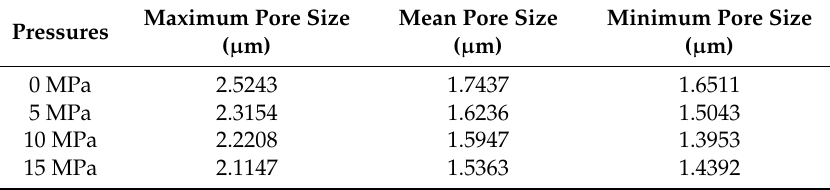
Table 2. Pore size of composite HNM under different pressures in hot pressing.